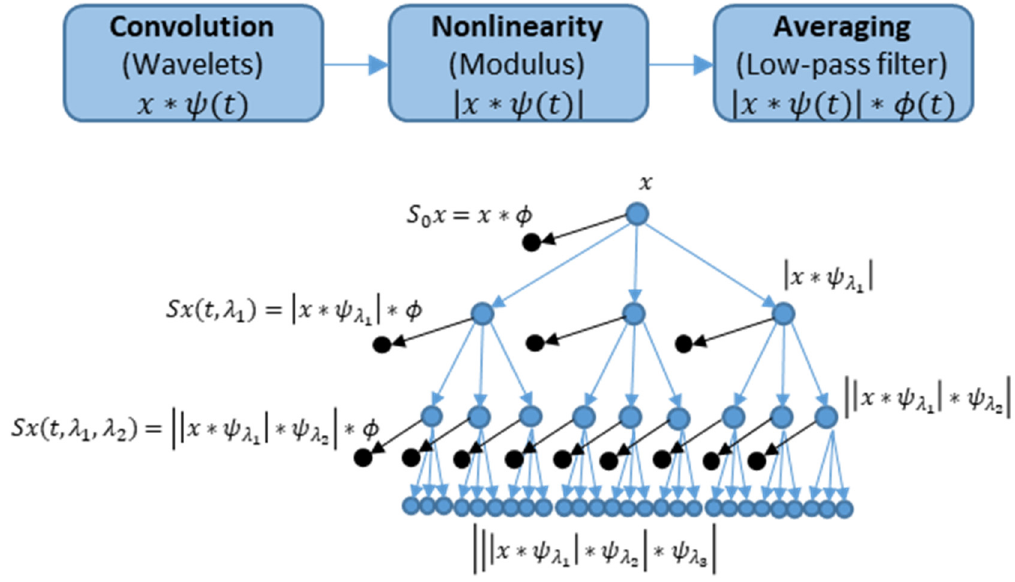
Figure 9. Wavelet scattering transform processes [60] ( top ) and wavelet scattering network [61] ( bottom ).